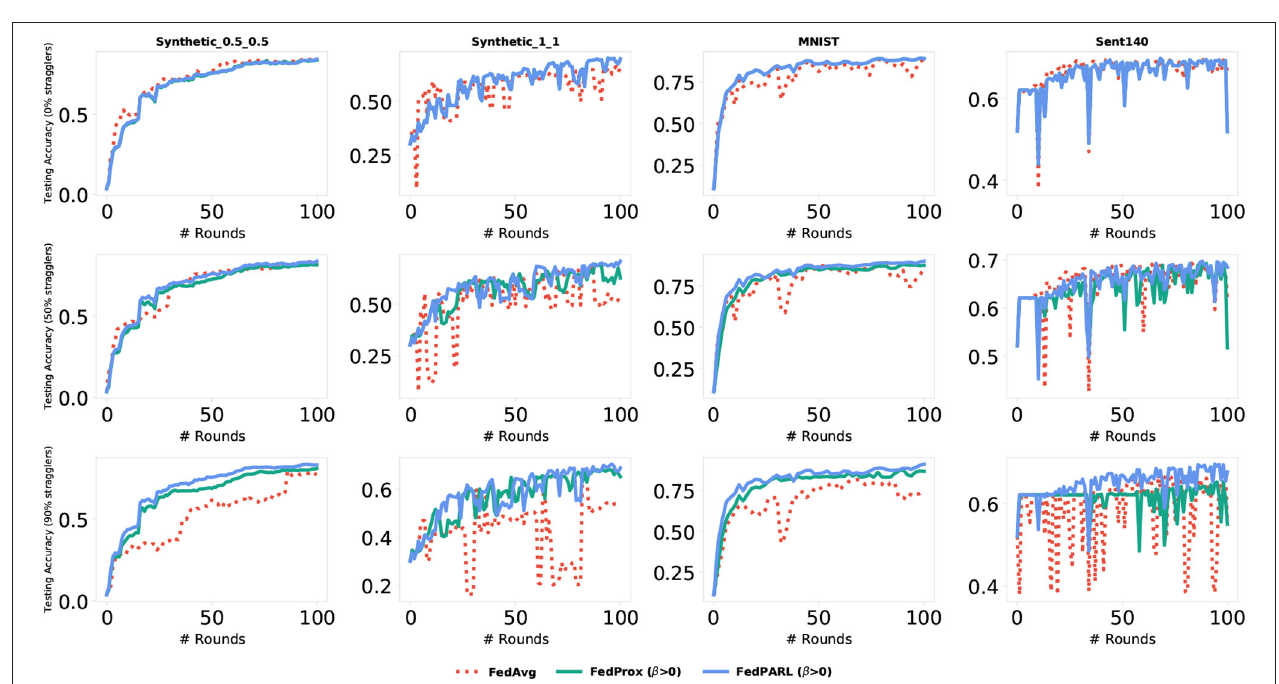
FIGURE 13 | Comparison of testing accuracy of our proposed FedPARL framework (considering β > 1) with FedAvg and FedProx in the presence of stragglers.